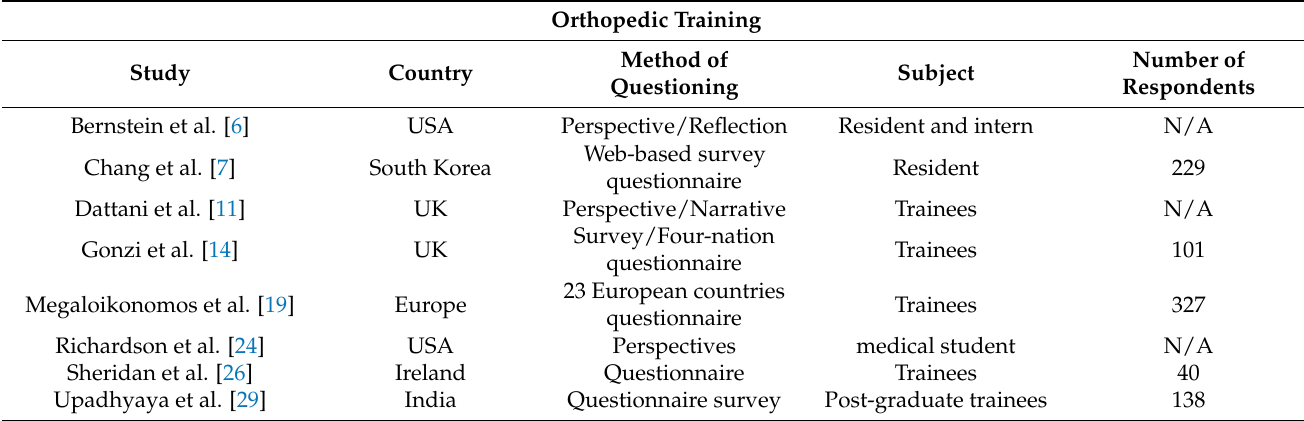
Table 2. Characteristics of relevant publications on orthopedic